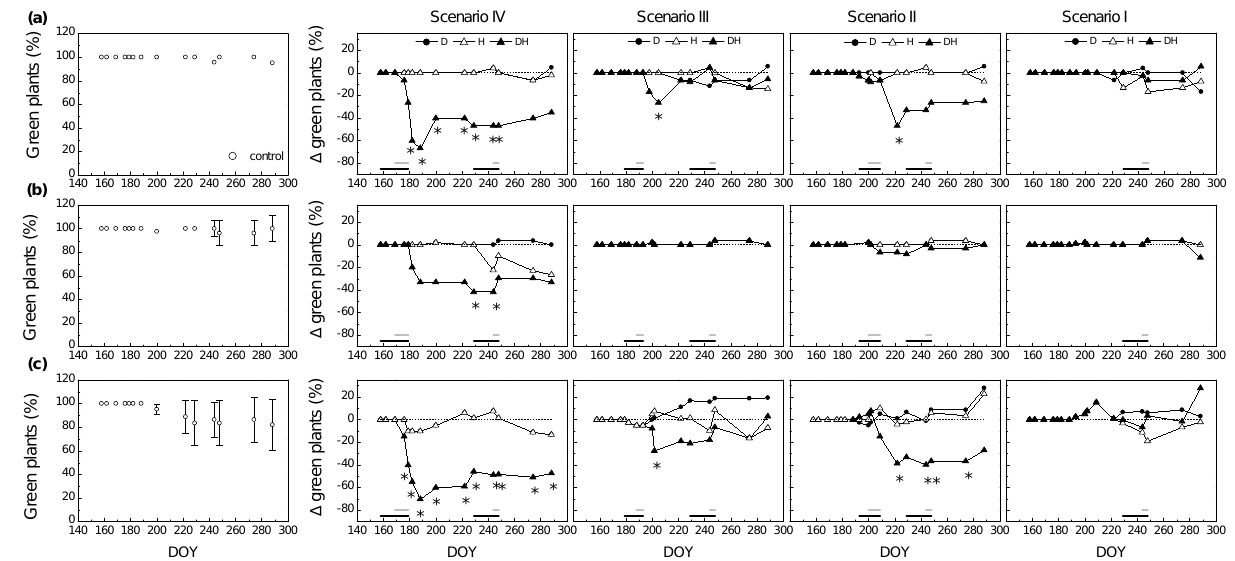
Fig. 4. Course of the percentage of green plants, per species, for (a) Rumex acetosella , (b) Plantago lanceolata and (c) Bellis perennis . Control values are given (left panel) and the difference between the controls and the treatments during the different scenarios. Standard errors are displayed for the controls but are not shown for the other treatments for improved clarity. D = drought (closed circles), H = heat (open triangles), DH = drought + heat (closed triangles). Bottom lines in each graph indicate timing of the climate events (black line = drought, grey line = heat wave). Asterisks, arranged in the same vertical order as the points, indicate significant differences ( P < 0 . 05) between treatments and control on that day. DOY = day of